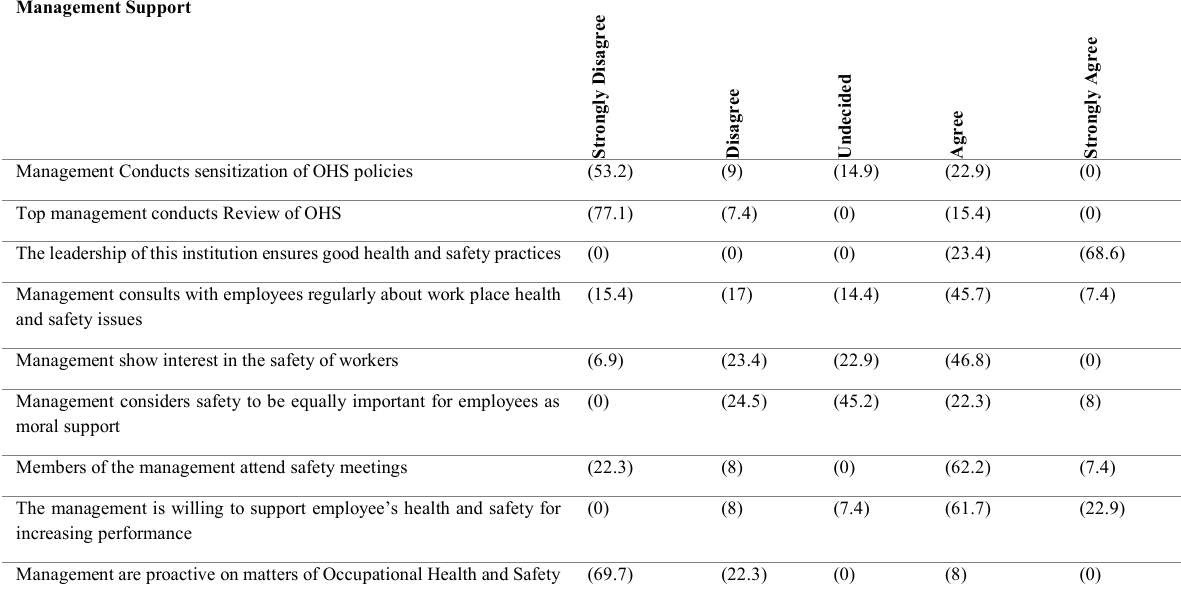
Table 1: Responses Management Support in